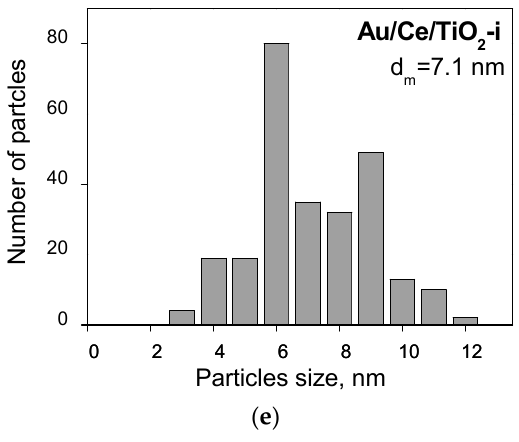
Figure 3. Au particle size distribution obtained by TEM for Au/TiO 2 ( a ); Au/La/TiO 2 -i ( b ); Au/Mg/TiO 2 -i ( c ); Au/Fe/TiO 2 -i ( d ); Au/Ce/TiO 2 -i ( e ).